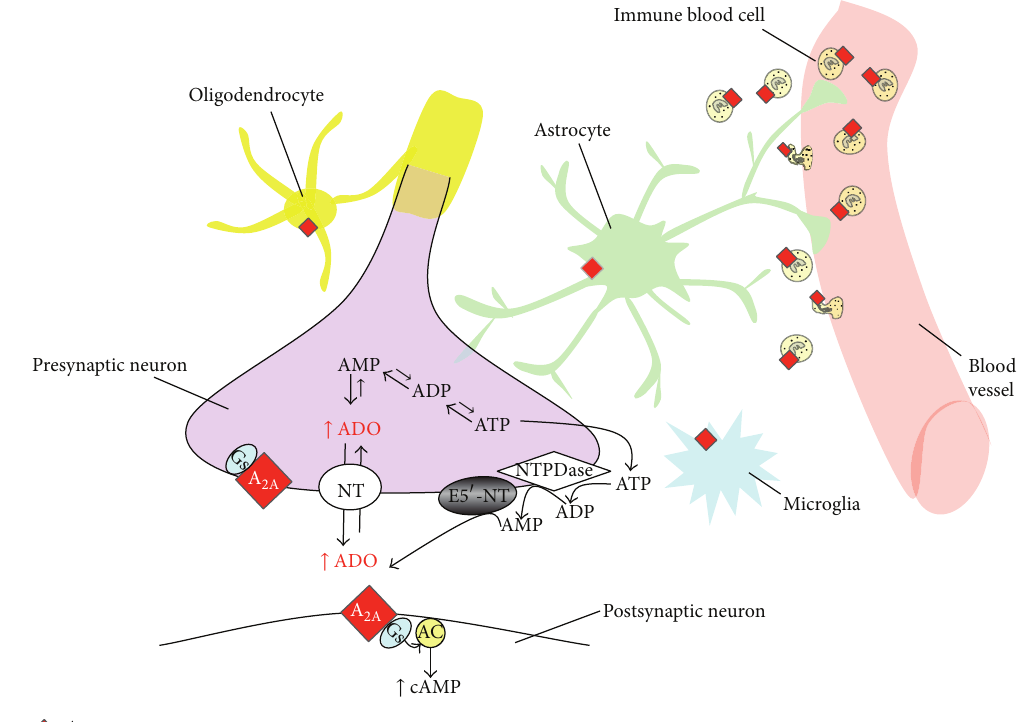
Figure 1: Schematic drawing of adenosine A 2 receptor localization on different cell types. Adenosine A 2 receptors are expressed at A A receptors are present central level on presynaptic and postsynaptic neurons, on astrocytes, on microglia, and on oligodendrocytes. A 2 A also at peripheral level on leukocytes and vasculature. After cerebral ischemia, leukocytes infiltrate into ischemic tissue due to increased permeability of blood-brain barrier (BBB). During ischemia, extracellular adenosine level increases mainly due to (i) extracellular ATP degradation by NTPDases; (ii) release of adenosine per se from cells likely by the equilibrative nucleoside transporter (ENT); (iii) inhibition of adenosine-uptake processes due to downregulation of concentrative nucleoside transporters (CNT) 2 and 3 and of ENT. AC: adenylate cyclase; ADO: adenosine; ADP: adenosine diphosphate; AMP: adenosine monophosphate; ATP: adenosine triphosphate; cAMP: cyclic adenosine monophosphate; E5 󸀠 -NT: ecto-5 󸀠 -nucleotidase; NT: nucleoside transporter; Gs: stimulatory 𝐺 -protein; NTDPase: ecto-nucleoside triphosphate diphosphohydrolases. The proportions of the various components of the nervous tissue have not been